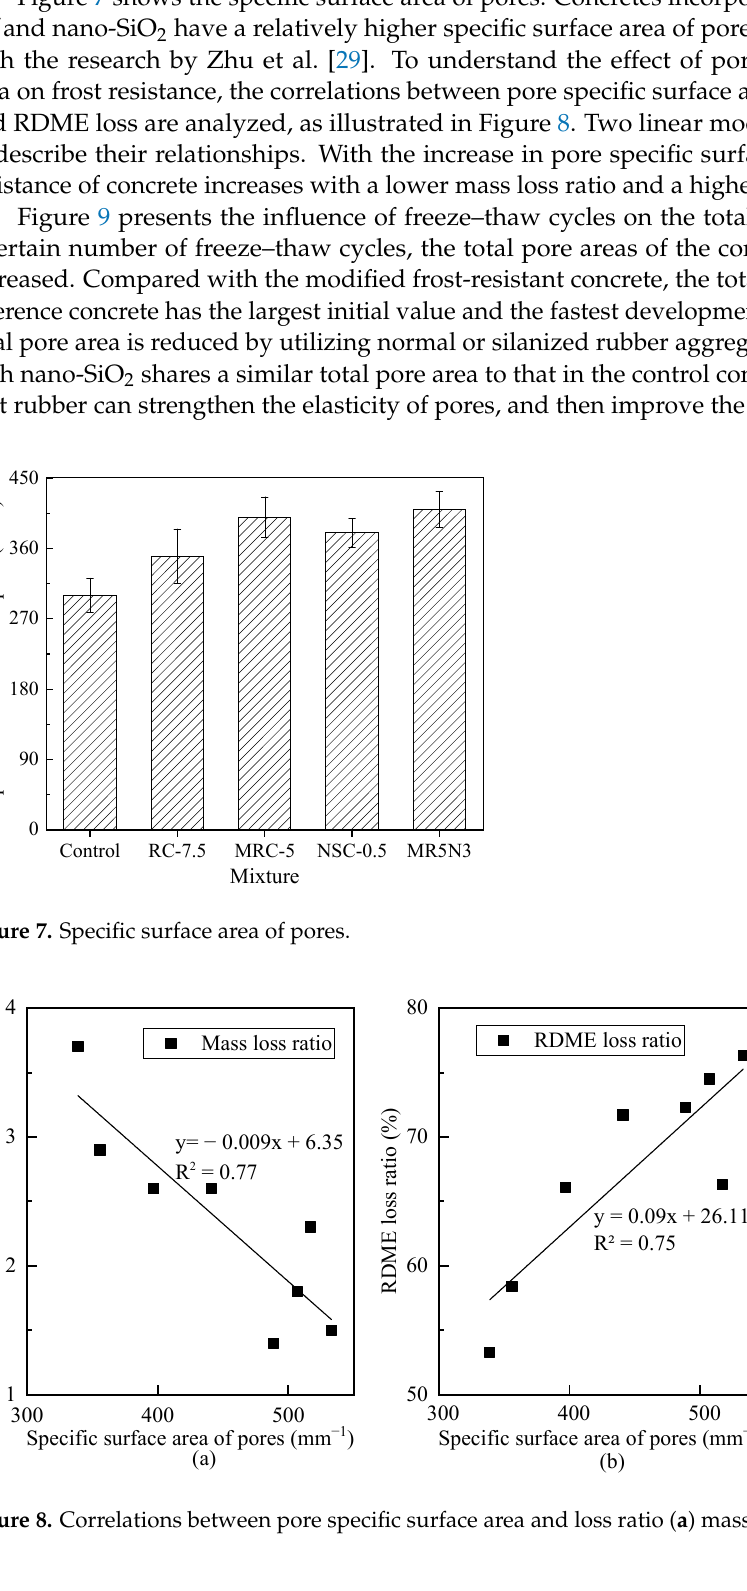
Figure 6. Percentages of pore types.